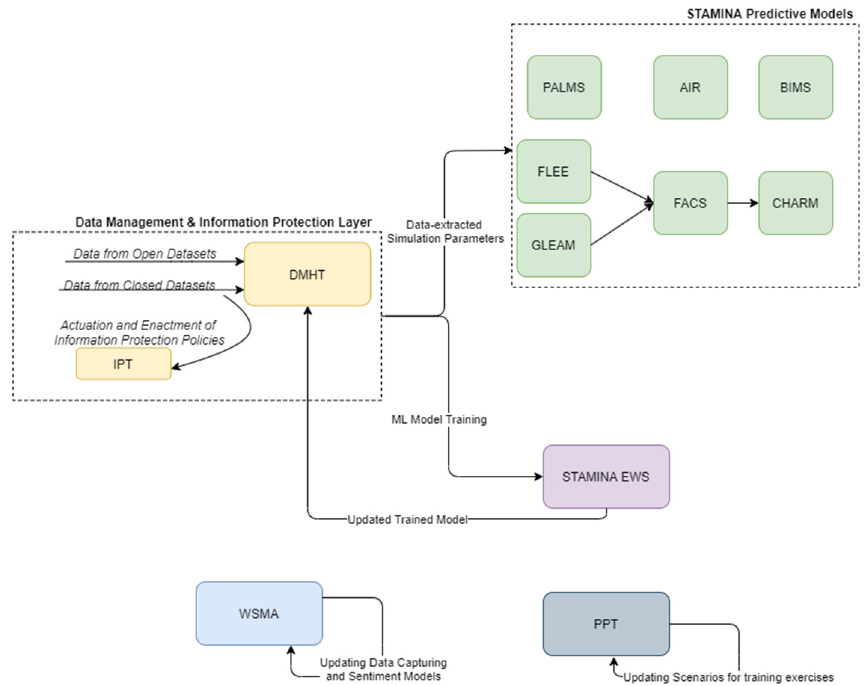
Figure 5. STAMINA Platform Recovery Phase.